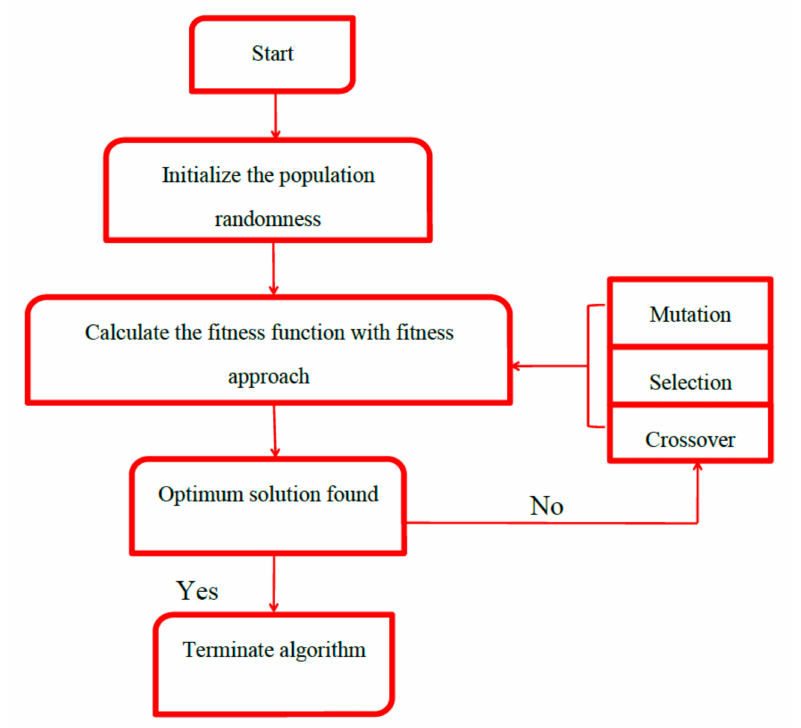
Figure 5. Flowchart of Genetic Algorithm (GA)